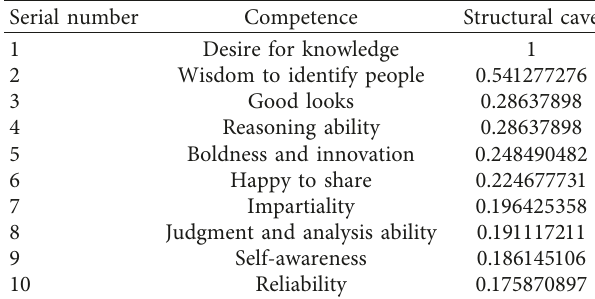
Table 3: Top 10 competencies occupying the structural hole